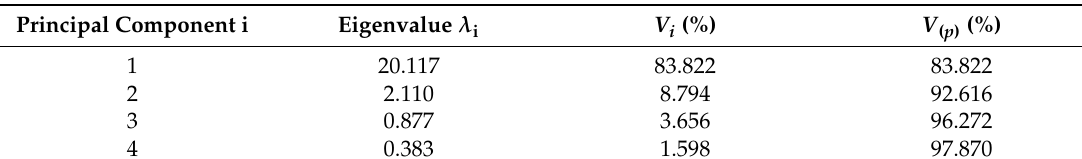
Table 4. Classification of fifteen exponential smoothing methods, by Taylor [113].